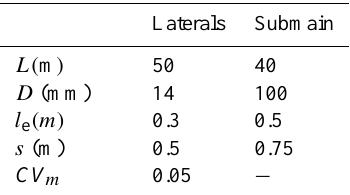
Table 2. Simulated SDI unit